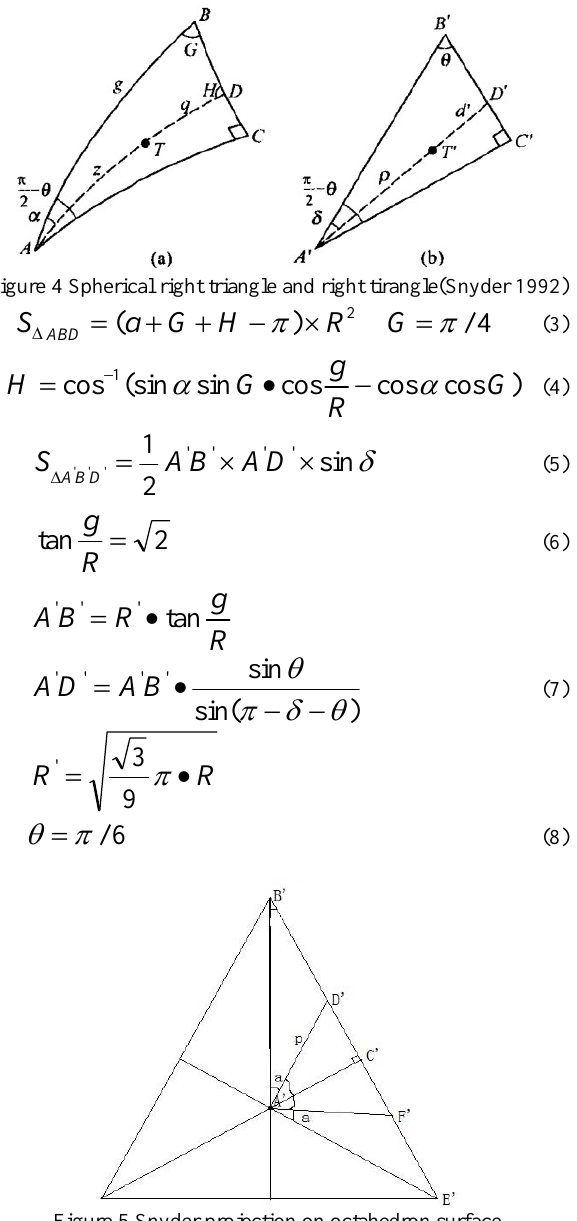
Figure 5 Snyder projection on octahedron surface To transfer octahedron surface equal-area cell onto sphere surface, back projection process of Snyder projection is implemented. The detailed process is shown as figure 6. Firstly, plane coordinates is set up, shown as figure 2. Then, values of ρ and δ are calculated according to coordinates (x, y) and formula 9. Next, S Δ ABD is computed by using formula 10. After that, sphere coordinate α and Z is acquired based on formula 11-17. Transferring result shows as figure 8. Figure 8.a shows the grids near the equation. Figure 8.b shows the result of Snyder projection near the pole from vertical